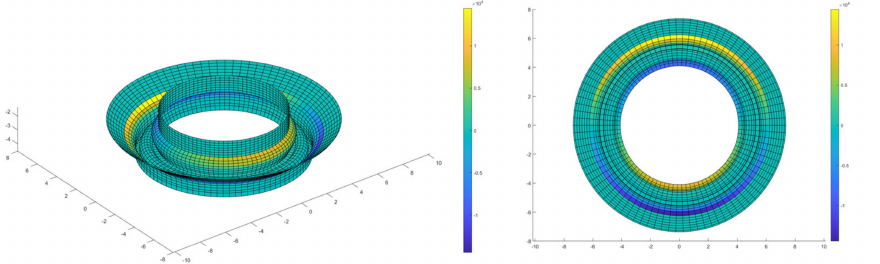
Figure 4. Model #1 features multiple poloidal (not helical yet) bridges located close to VV and fed by halo currents harmonically distributed around the torus. Yellow and blue areas indicate injection pattern of anti-symmetric Halo component at a sample time instant. In this model halo current can flow from yellow to blue area through the bridges only in poloidal